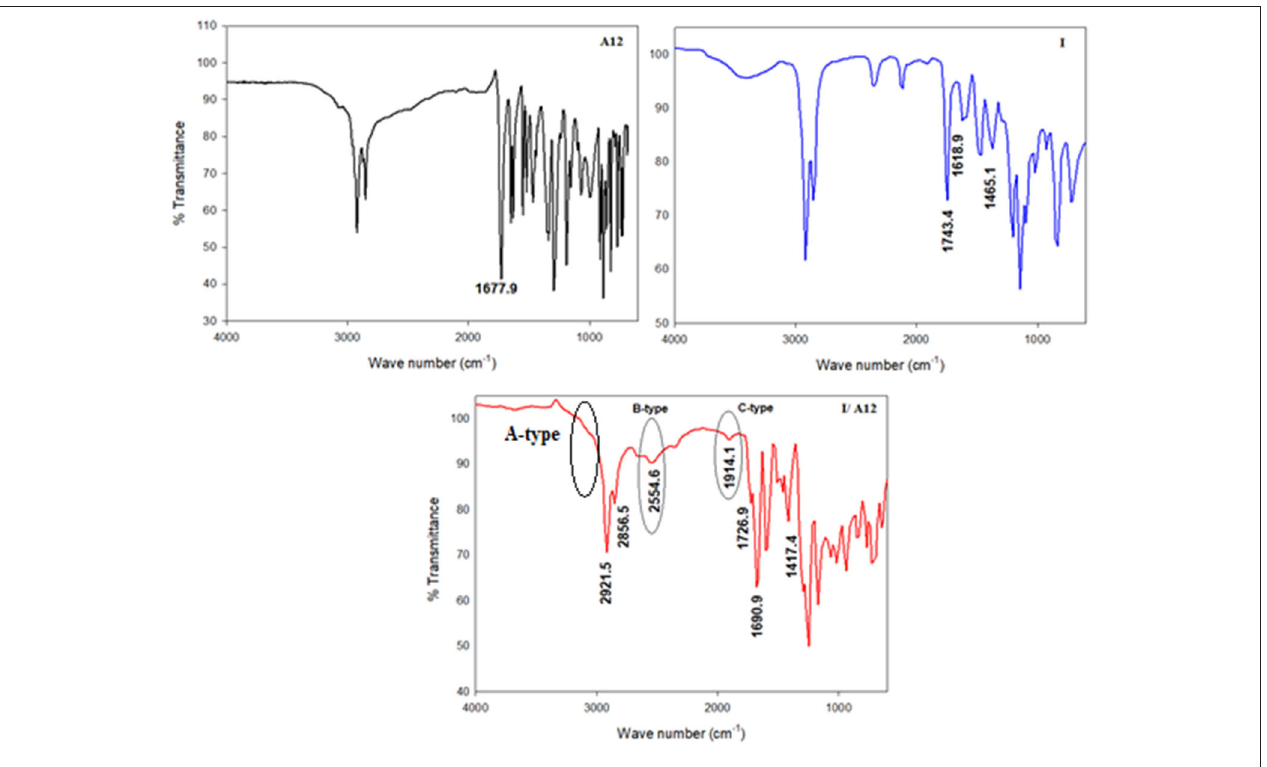
FIGURE 1 | FT-IR spectra of I , A 12, and I/A 12 .